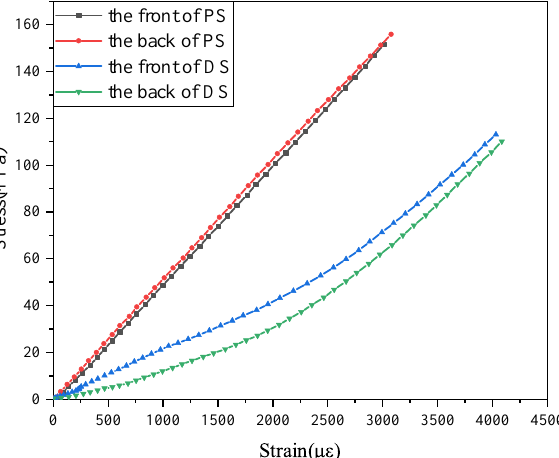
Figure 3. Stress–strain curve of the pristine specimen (PS) and delaminated specimen (DS) under compressive loading (0–3000 µ ε ).